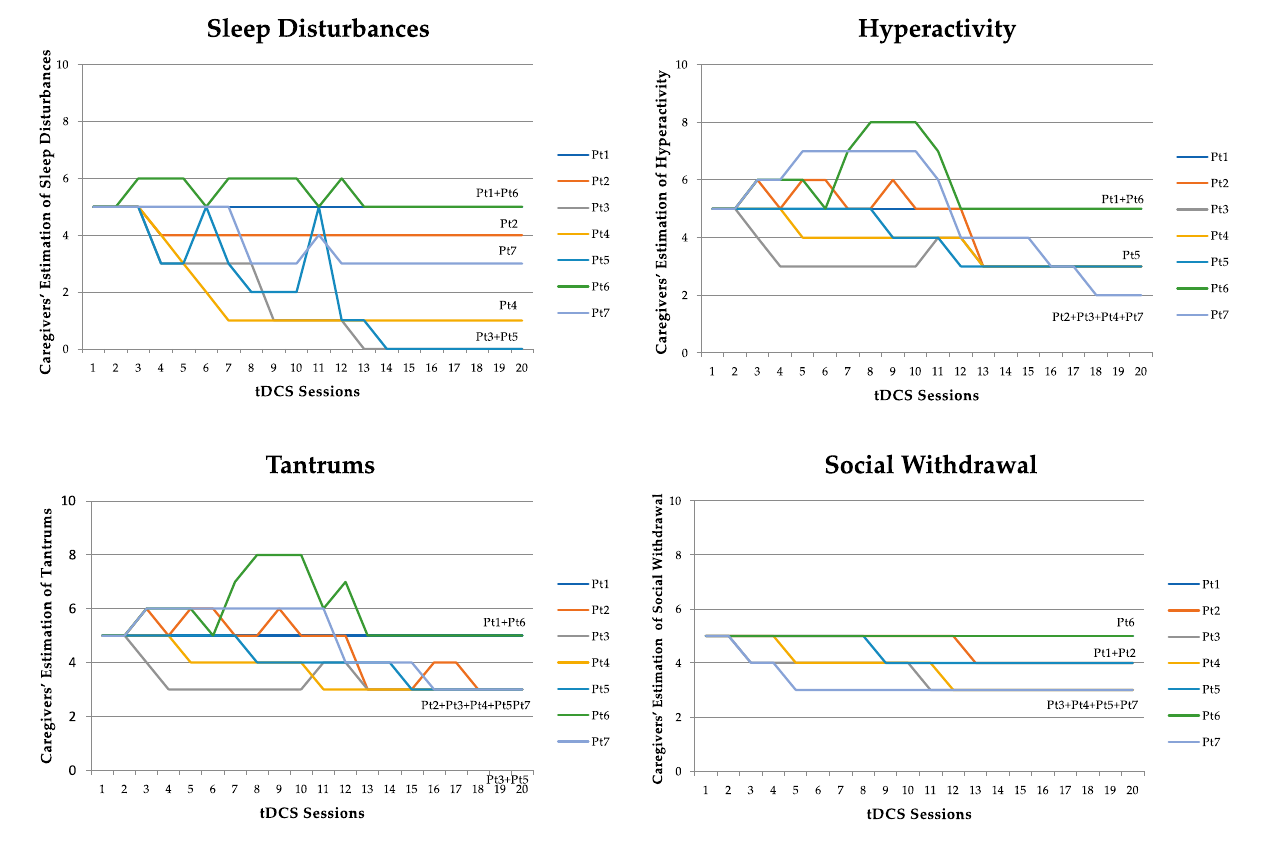
Figure 2. The four graphs display the severity rating of the four behavioral symptoms indicated as the most disturbing by the patients’ caregivers, throughout the 20 daily tDCS sessions. One stripe in a graph corresponds to one patient. The same patient is represented with the same color in all four graphs. In the y-axis, 5 corresponds to “symptom unchanged”, 0 corresponds to “very much improved/symptom absent”, and 10 corresponds to “very much worsened/worst-ever severity of the symptom”. Pt =